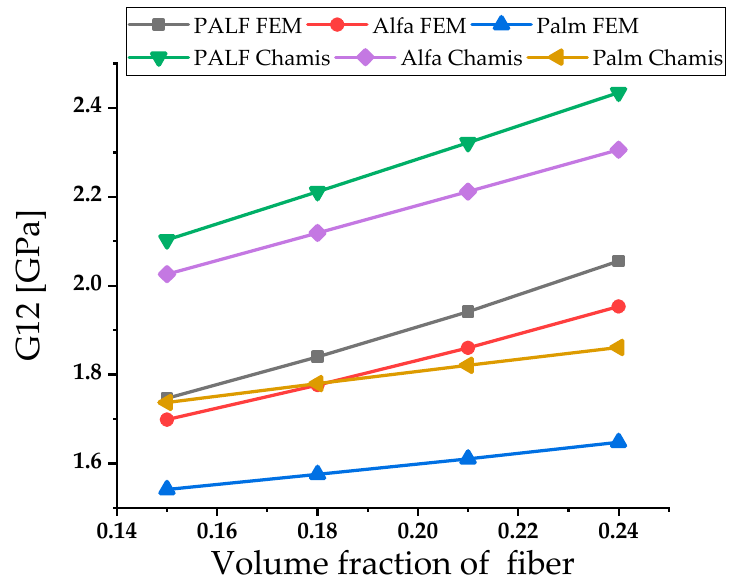
Figure 13. Predicted analytical (Chamis model) and numerical results for Shear Modulus G 12 in terms of V F .